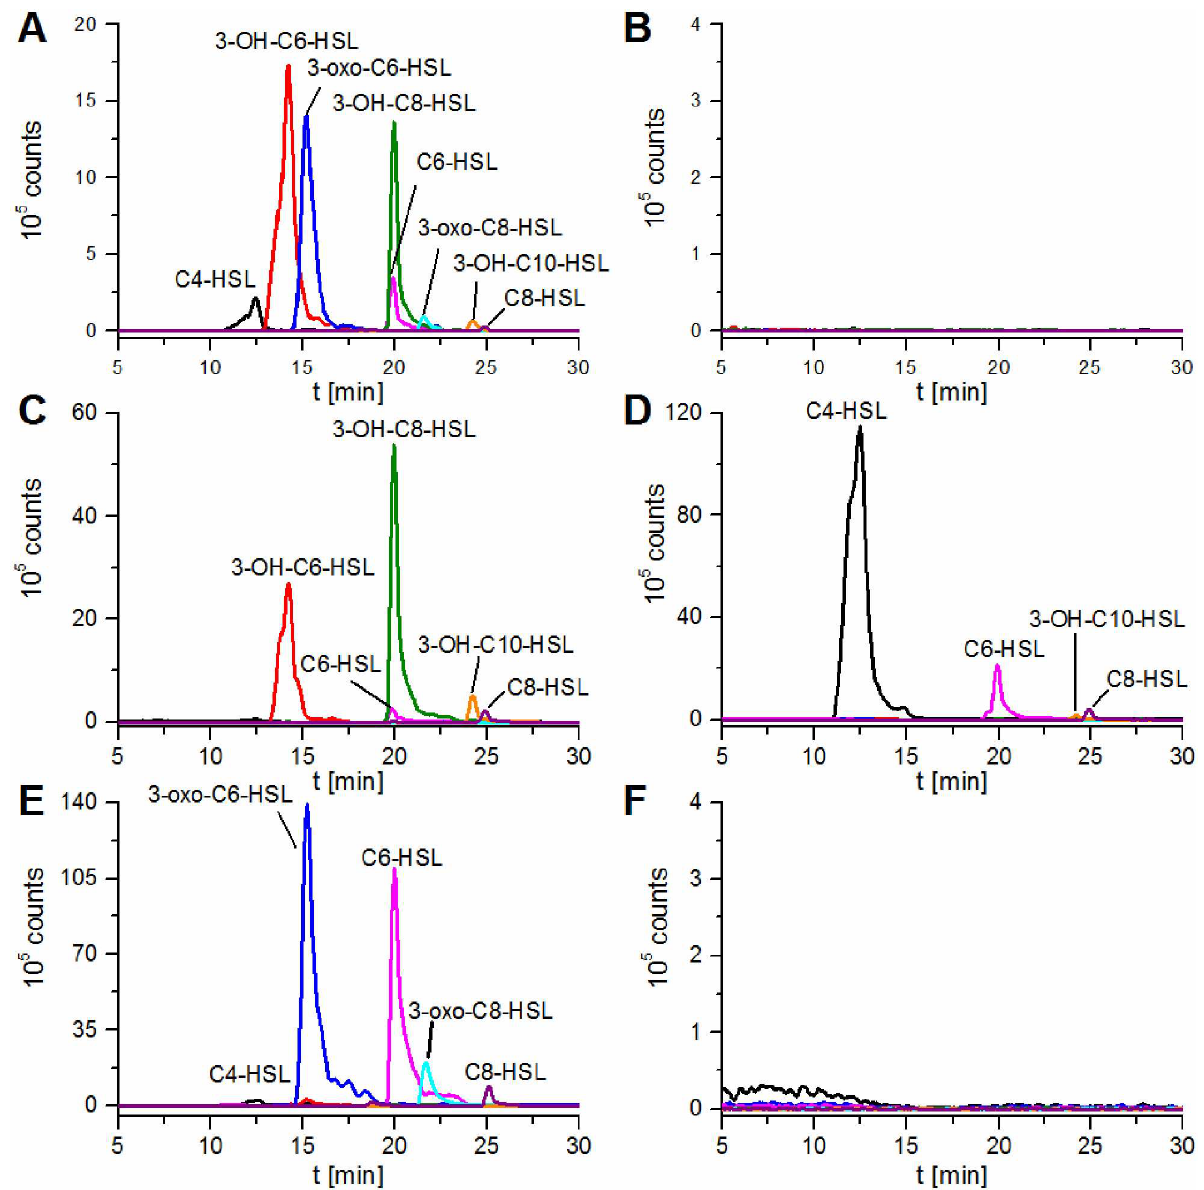
Fig 2. Identification of the produced AHLs using LC-MS/MS. Extracted ion chromatograms (LC-MS/MS, precursor ion scan, positive ionizationmode) of [M+H] + ions of AHLs present in (A) P . aurantiaca PB-St2 crude extract after 22 h cultivation,(B) E . coli XL1-Blue/ pBluescript SK(-) Δ lacZ crude extract, and extracts of E . coli XL1-Blue expressing(C) phzI , (D) csaI , (E) aurI , and (F) hdtS . C4-HSL (black, m/z 172–173),3-OH-C6-HSL (red, m/z 216–217),3-oxo-C6-HSL (blue, m/z 214–215), C6-HSL (pink, m/z 200–201),3-OH-C8-HSL (green, m/z 244–245),3-oxo-C8-HSL (cyan, m/z 242–243),3-OH-C10-HSL (orange, m/z 272–273), C8-HSL (purple, m/z